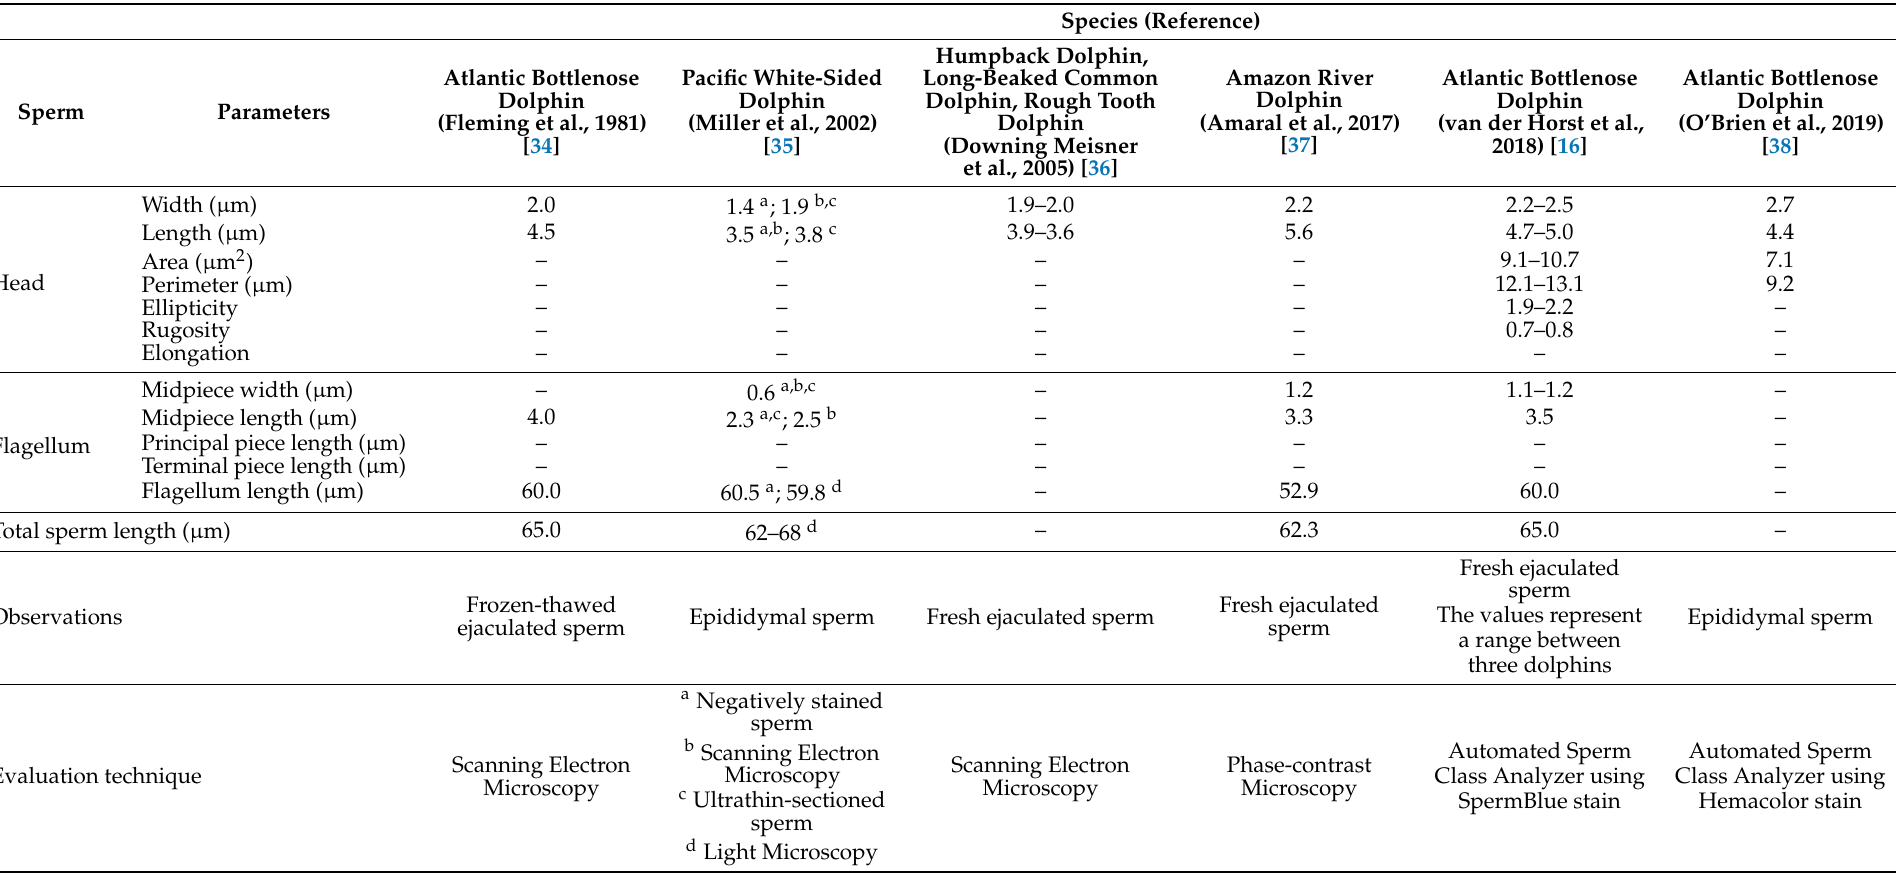
Table 1. Comparative table of sperm morphometric parameters reported in different dolphin